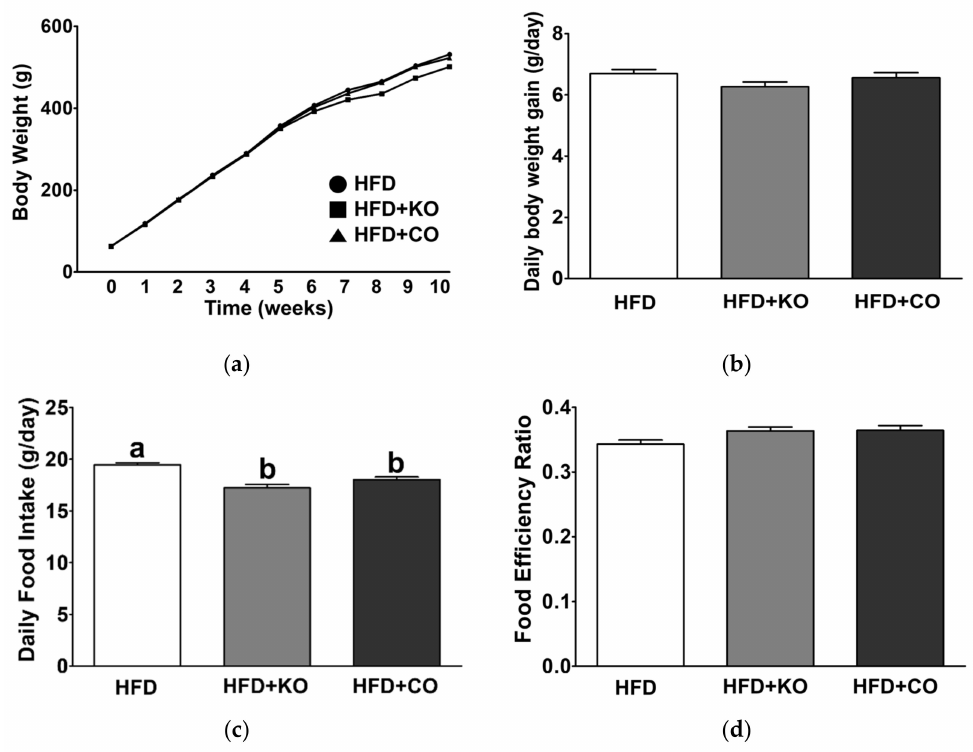
Figure 1. Effects of partial replacement of dietary fat with krill oil or coconut oil on the body weight, daily body weight gain, food intake, and food efficiency ratio in HFD-fed rats. Sprague Dawley rats were fed either a high-fat diet (HFD; open box), HFD partially replaced with krill oil (HFD + KO; gray-filled box), or coconut oil (HFD + CO; black-filled box) for 10 weeks. ( a ) Body weight changes, ( b ) daily body weight gain, ( c ) daily food intake, and ( d ) food efficiency ratio (FER) were measured. Values are presented as means ± SD; n = 16 per individual group. Data were analyzed using one-way ANOVA followed by Tukey’s multiple comparisons test; labeled means without a common letter differ significantly, p < 0.05. HFD, high-fat diet; HFD + KO, high-fat diet + krill oil; HFD + CO, high-fat diet + coconut